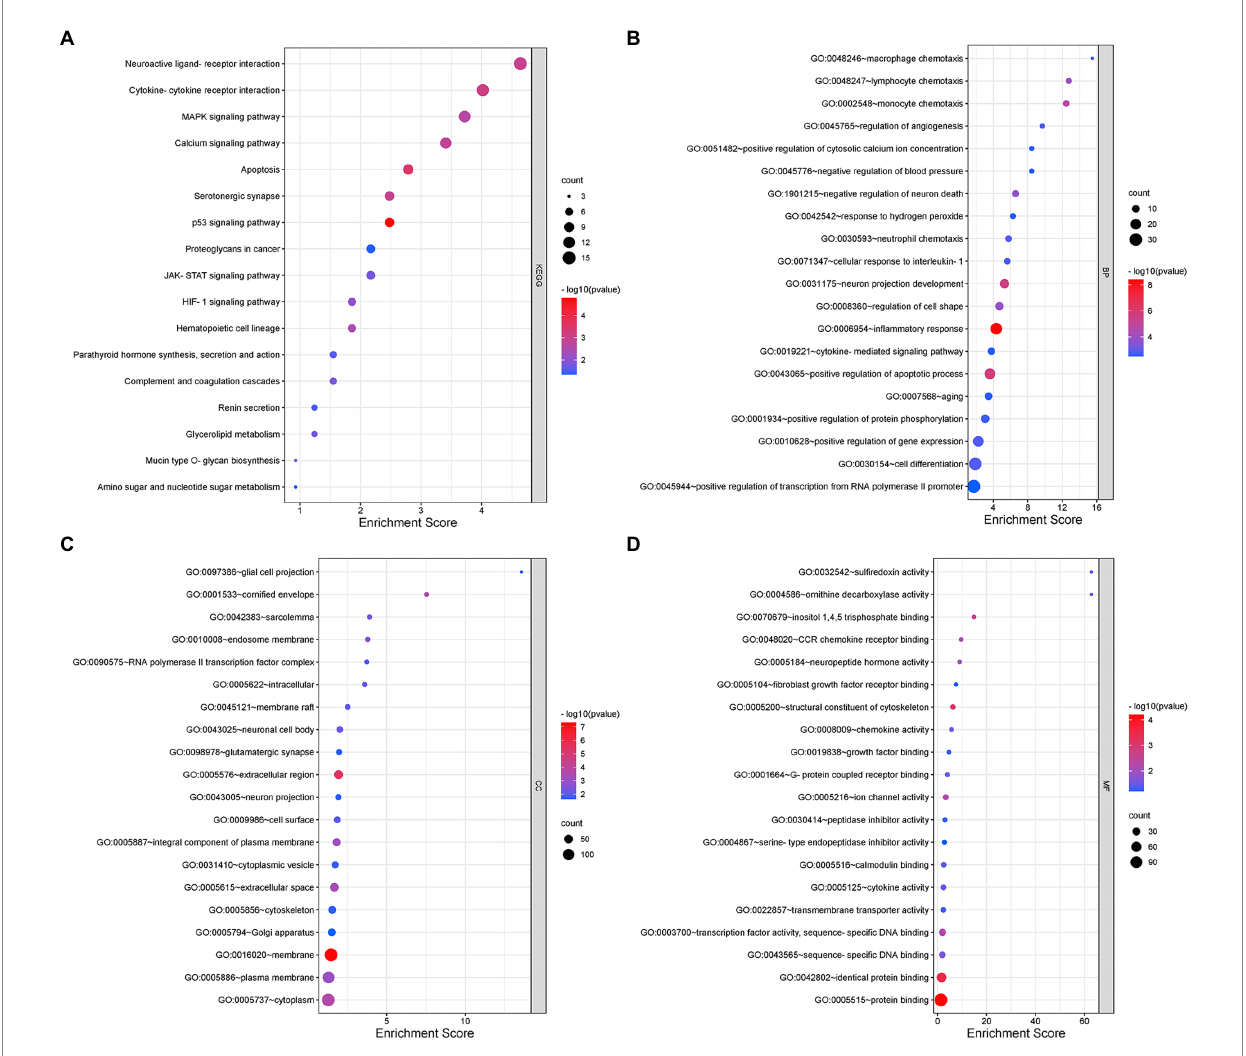
FIGURE 2 Gene Ontology (GO) and Kyoto Encyclopedia of Genes and Genomes (KEGG) analyses for DEmRNAs. (A) KEGG pathway analysis shows the significantly enriched pathways and their gene counts. (B–D) The GO enrichment results of DEmRNAs, including GO-BP (B) , GO-CC (C) , and GO-MF (D)